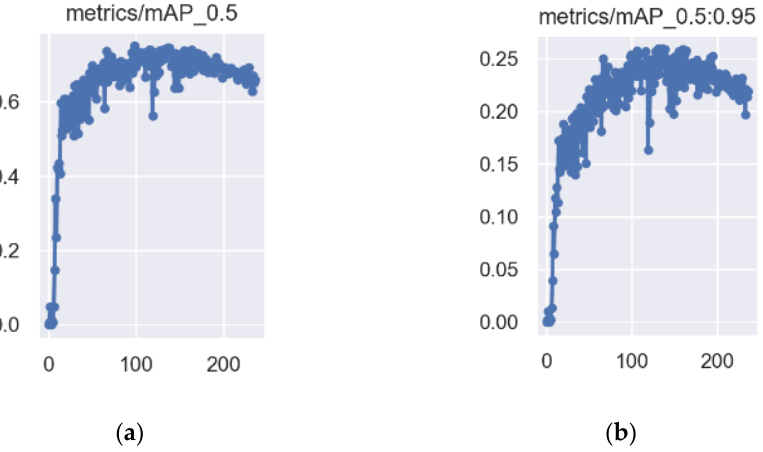
Figure A15. The change of mean average precision (mAP) of YOLOV5x: ( a ) mAP_0.5; ( b ) mAP_0.5:0.95.